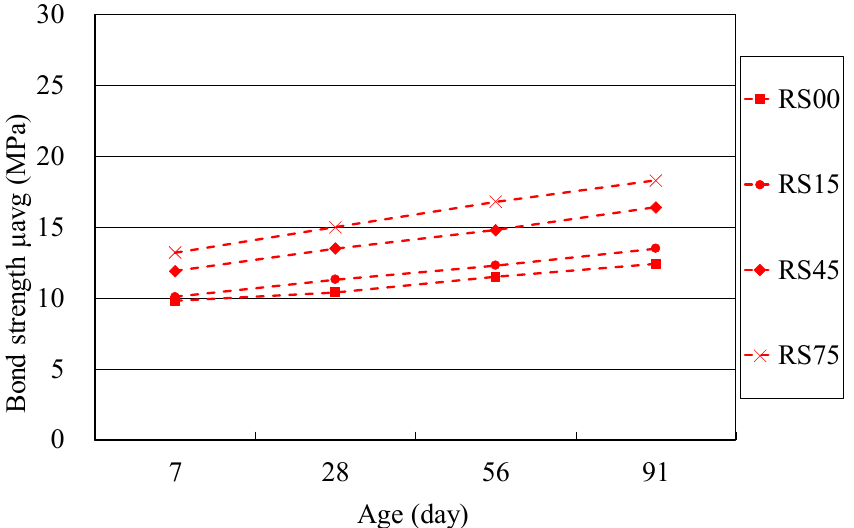
Figure 6. Bond strength of RAC versus curing age.